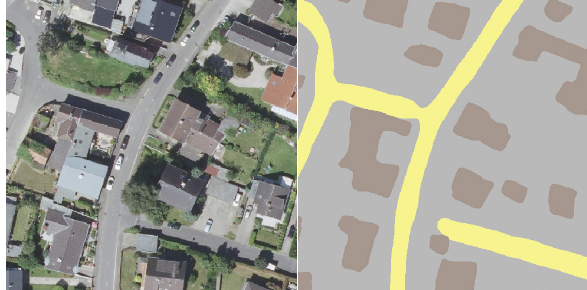
Figure 4. On the left aerial image that serves as input to the image segmenter. On the right segmented image. Building footprints in brown and roads in